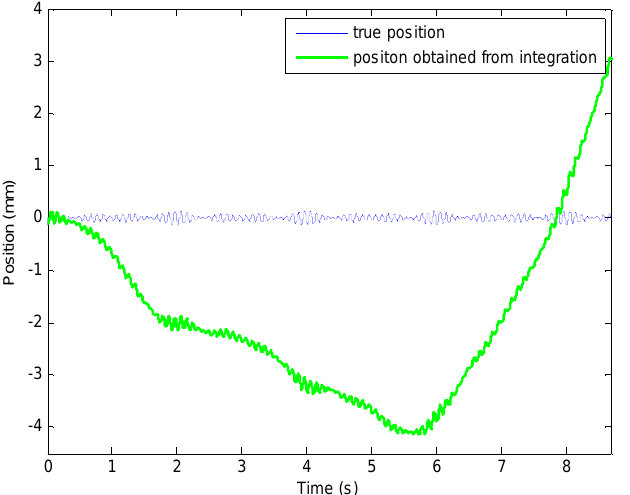
Figure 9. True position and position obtained from double-integration of simulated